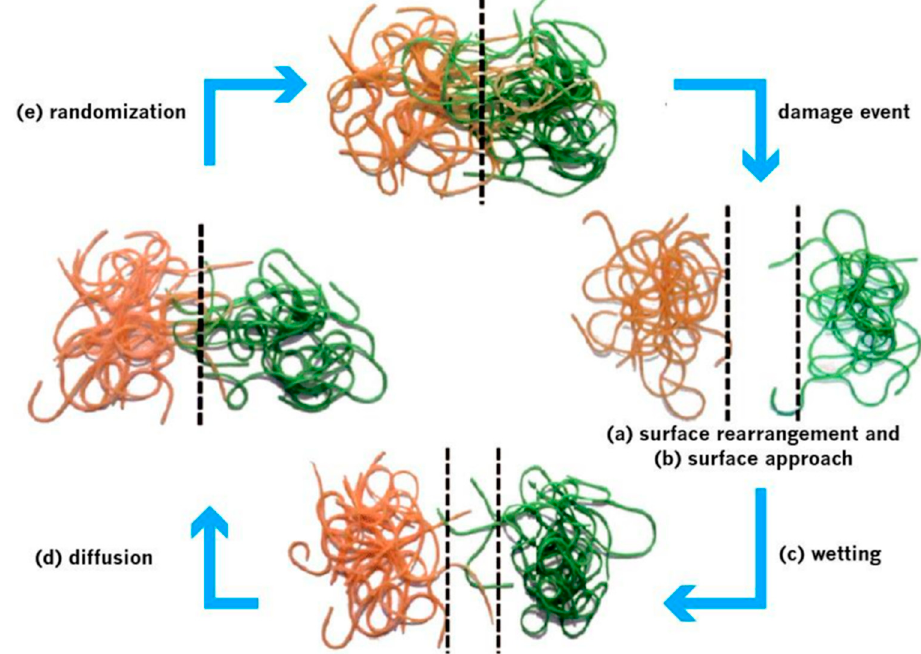
Figure 3. Five stages of the self-healing mechanism. ( a ) Re-arrangement of surface, ( b ) surface approach, ( c ) wetting, ( d ) diffusion, and ( e ) randomization. (Adapted from [37,39]). ( c ) wetting, ( d ) di ff usion, and ( e ) randomization. (Adapted from